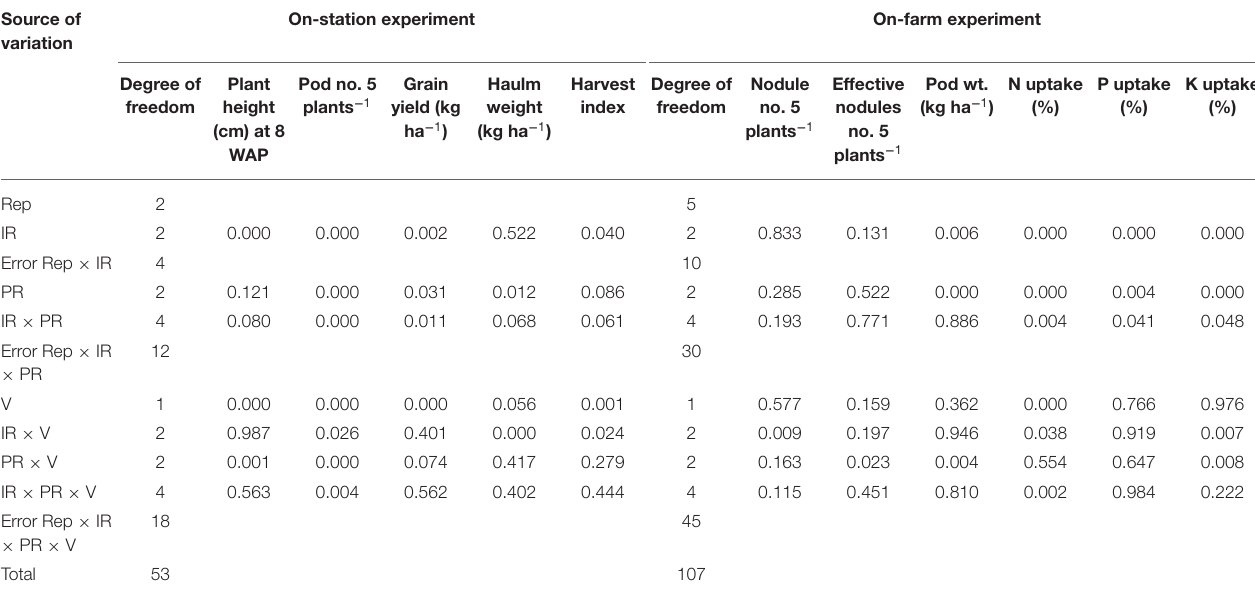
TABLE 2 | Summary of ANOVA for variety (V), phosphorus (PR), and rhizobium inoculant rate (IR) effects on plant height, nodulation, yield, and yield components of groundnut in the on-station and on-farm experiments. Source of